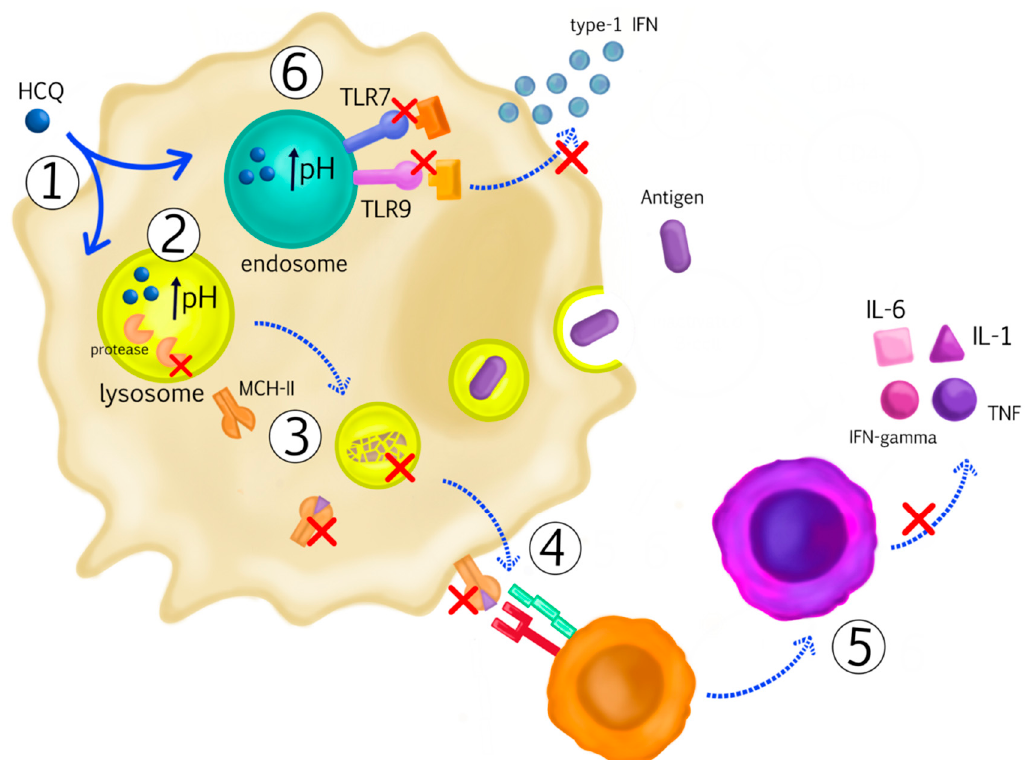
Figure 4. Suggested mechanisms of the anti-inflammatory and immunomodulatory effects of HCQ. 1. HCQ has a hydrophilic nature, can pass through cell membranes easily and accumulates in intracellular vesicles, including lysosomes, endosomes and autophagosomes. 2. Raising the pH in the acidic vesicles precludes proper functioning of vesicular enzymes. 3. HCQ prevents the presentation of peptides for major histocompatibility complex (MHC)-II, by interfering with the conversion of antigens to peptides in antigen-presenting cells. Hence, extracellular material may accumulate less under the retina. 4. HCQ prevents peptides from interacting with MHC-II in the loading compartment of acidic endosomes on MHC-II. 5. HCQ inhibits cytokine release by interfering with MHC-II-related autoantigen presentation to cluster of differentiation (CD) 4+ T-cells, via antigen- presenting cells. This prevents CD4+ T-cells from activating B-cells. HCQ causes autoreactive T-cells from undergoing apoptosis and obstructs B-cells from processing antigens. The result is impaired function and production of cytokines, including interleukin [IL]-1, IL-6, interferon-gamma, tumor necrosis factor and B-cell activating factor. 6. The binding of immune complexes to TLR7 and TLR9 results in the downstream stimulation of type-1 interferon transcription. Type-1 interferons trigger the generation of additional cytokines by activating T-cells, B-cells, natural killer cells, myeloid dendritic cells and monocytes. The binding of TLR7 and TLR9 to the immune complexes is directly inhibited by the accumulation of HCQ in endosomes that contain TLR7 and TLR9. HCQ can potentially hinder the processing of TLRs by raising the pH of the endosome. Thus, HCQ reduces the transcription of type-1 interferons by interfering with TLR7 and TLR9 signaling; this has immunomodulatory and anti-inflammatory